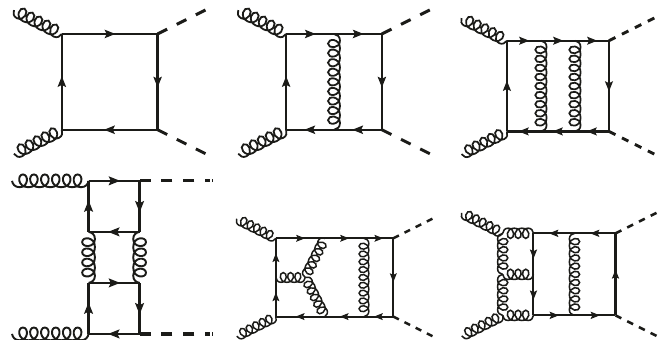
Figure 4 . Sample one-, two-, three- and four-loop diagrams contributing to A h